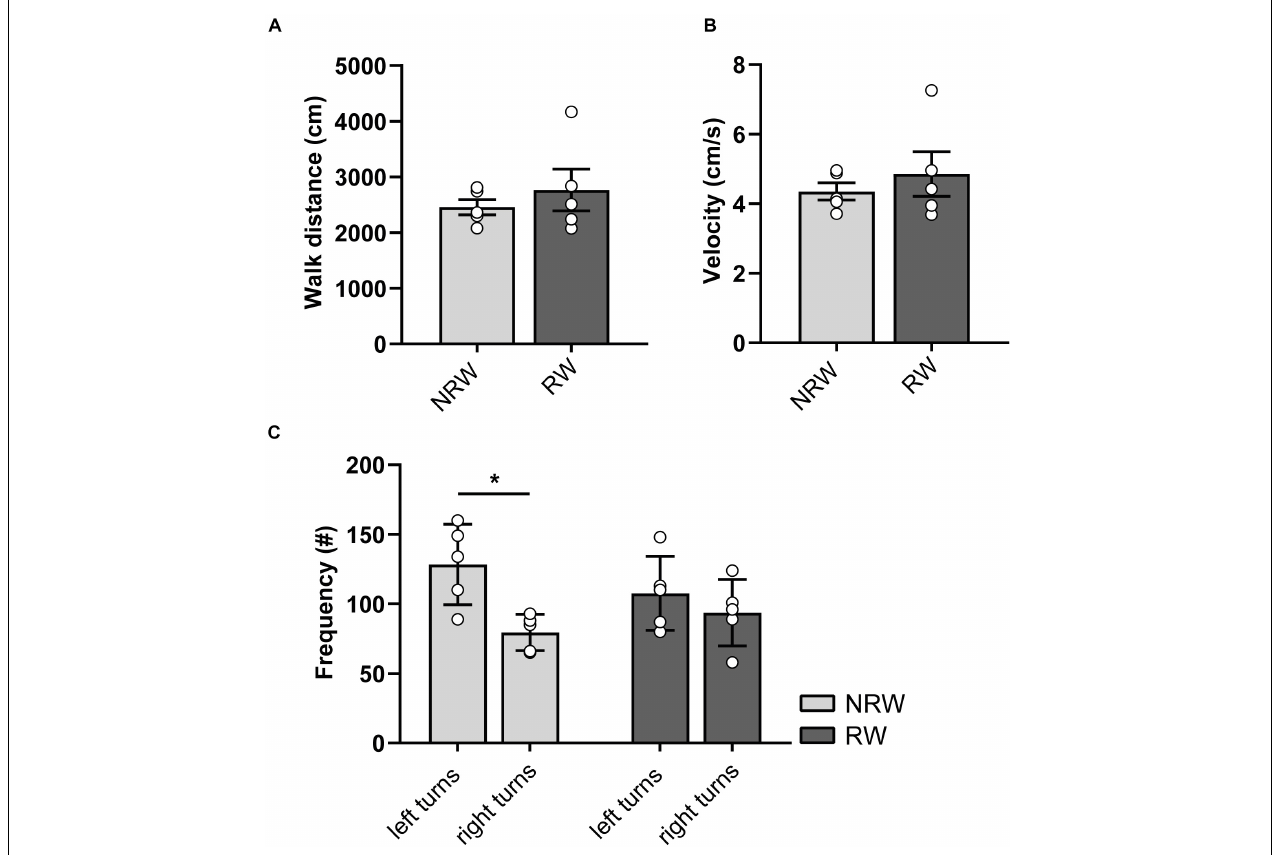
FIGURE 4 | (A) Distance and (B) velocity determined during 10 min open field performed 6 days after surgery. The total distance traveled and velocity did not differ between the experimental groups. (C) Turning direction frequency, measured in RW and NRW animals during the open field. RW: N = 5, NRW: N = 5; values represented in mean ± SEM. * p ≤ 0.05.